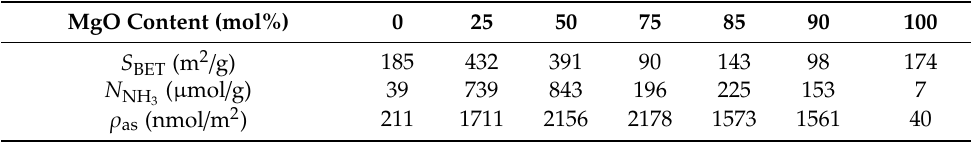
Table A2. Characterization results of the textural and surface acid investigations on the binary M1 / SiO 2 mixed oxides and the precursors M1 and SiO 2 , shown in Figure